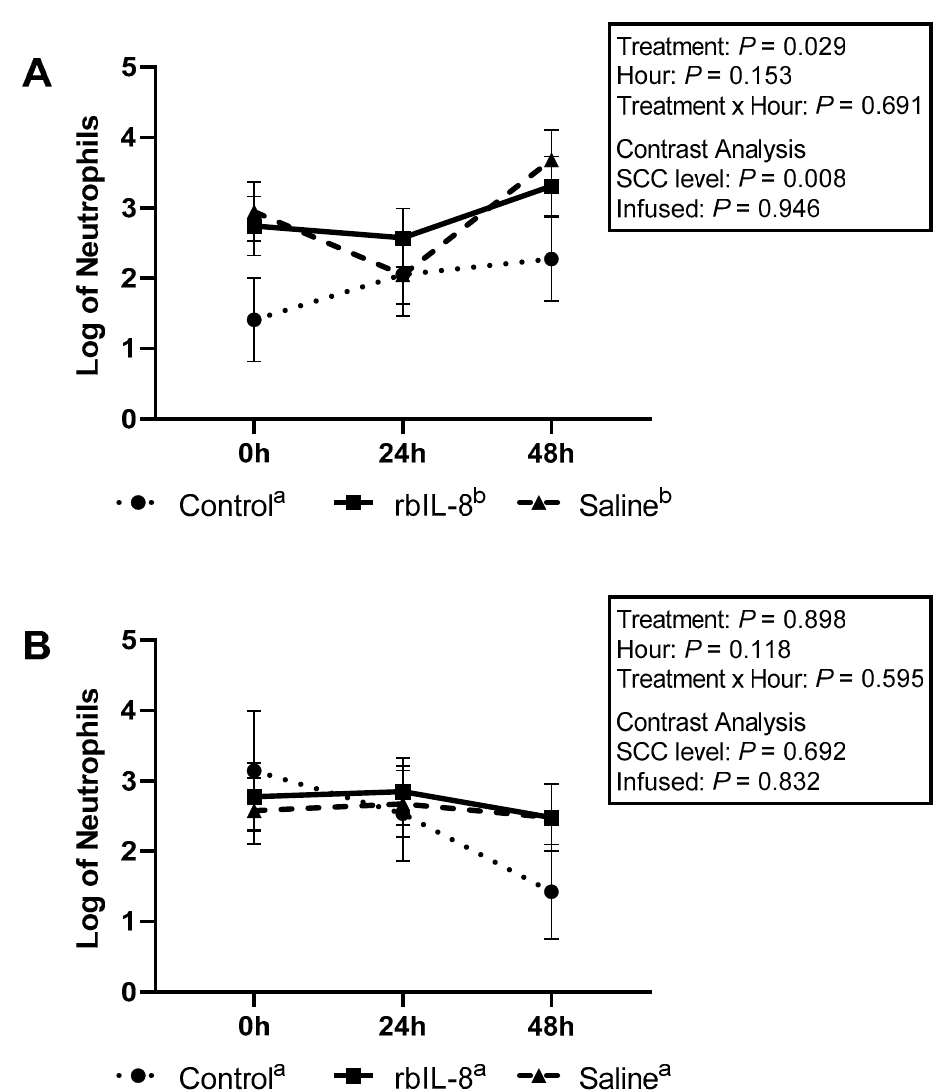
Figure 4. Log of neutrophils isolated from milk ( A ) and from blood samples ( B ) that presented a high fluorescence only for dihydrorhodamine 123 (DHR) relative to hours post-treatment based on flow cytometry. The treatment effect is a multiple comparison analysis among the groups. The SCC level was measured using a contrast comparing the chronic groups (rbIL-8 and saline) to the control, whereas the infused was compared to the rbIL-8 with the saline. Multiple comparisons were adjusted for Tukey–Kramer. Groups with different superscripts a,b differed for the mean ± SE of log of neutrophils, in the multiple comparison analysis; p = ≤ 0.05 means a statistical significance, and 0.05 < p ≤ 0.10 means a statistical tendency.